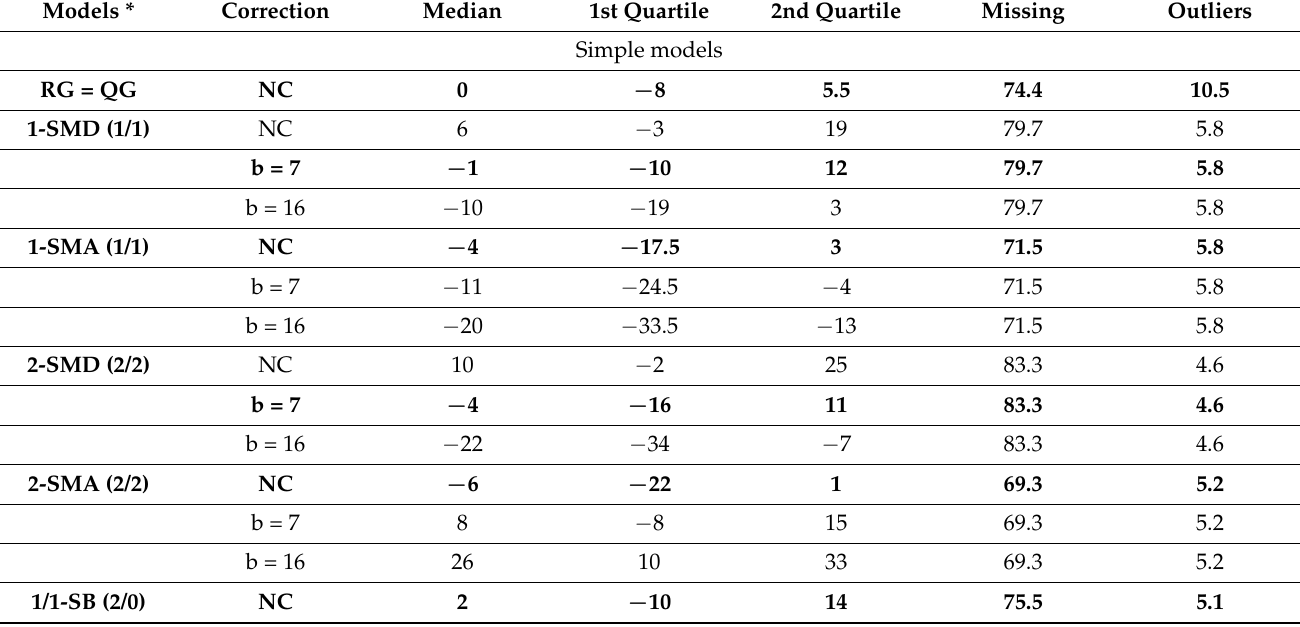
Table 1. Estimates for sampling times of a queried SARS-CoV-2 genome. We report the median of the individual values and the interquartile ranges of the medians. ‘Missing’ refers to the percentage of genomes that do not satisfy the necessary conditions for each model, e.g., not all the QG have matched RGs in the phylogeny. The outlier values represent the proportion of estimations with values above 3rd quartile +1.5 IQR (interquartile range), or below 1st quartile +1.5 IQR quartile +1.5 IQR. In bold are the best corrections within models. In brackets: number of different substitutions between the RG and the QG/Beta value coefficient. Abbreviations: NC = no correction; 1-SMD = RG is a 1-step mutational derivative from QG; 1-SMA = RG is a 1-step mutational ancestor from QG; 1/1-SB = RG and QG are in sister branches of 1-step mutational length each; 2-SMD = RG is a 2-step mutational derivative from QG; 2-SMA = RG is a 2-step mutational ancestor from QG; 3-SMD = RG is a 3-step mutational derivative from QG; 3-SMA = RG is a 3-step mutational ancestor from QG; 2/1-SB = RG and QG are in sister branches, the length of the RG branch is 2 substitutions and the length of QG is 1 substitution; 1/2-SB = RG and QG are in sister branches, the length of the RG branch is 1 substitution and the length of QG is 2 substitution; 1-M_SM = RG match or is a 1-step mutational ancestral or derivative from QG; 1/2-M_SM = RG match or is a 1 or 2-step mutational ancestral or derivative from QG; 1/2/3-M_SM = RG match or is a 1, 2 or 3-step mutational ancestral or derivative from QG. See also Figure